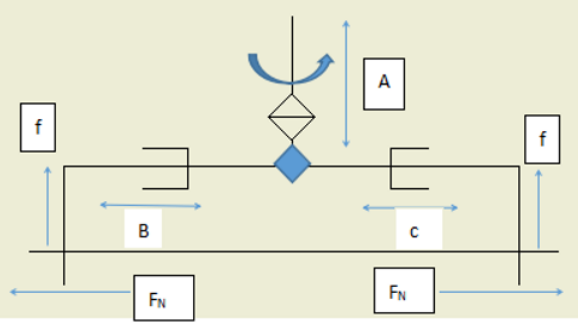
Fig. 3. Schematic diagram of jaw structure.